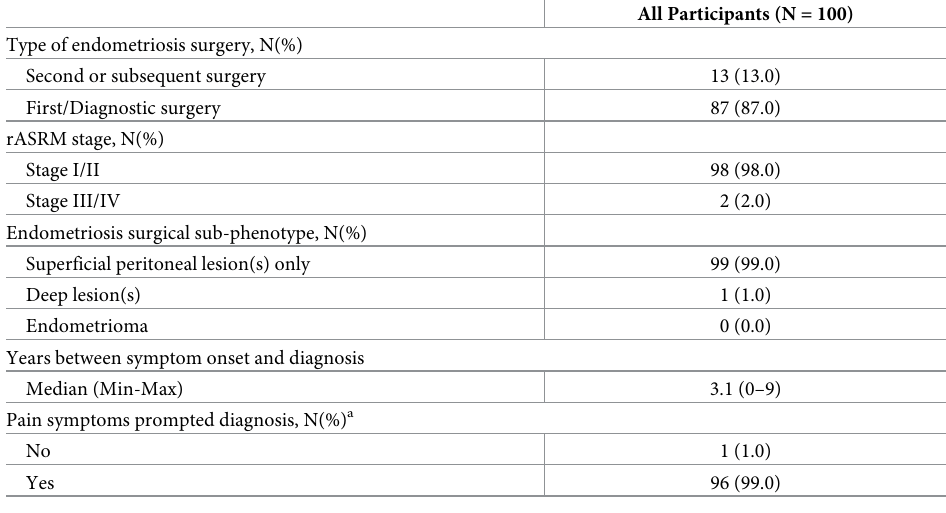
Table 2. Surgical and endometriosis-related characteristics of EndoQUEST